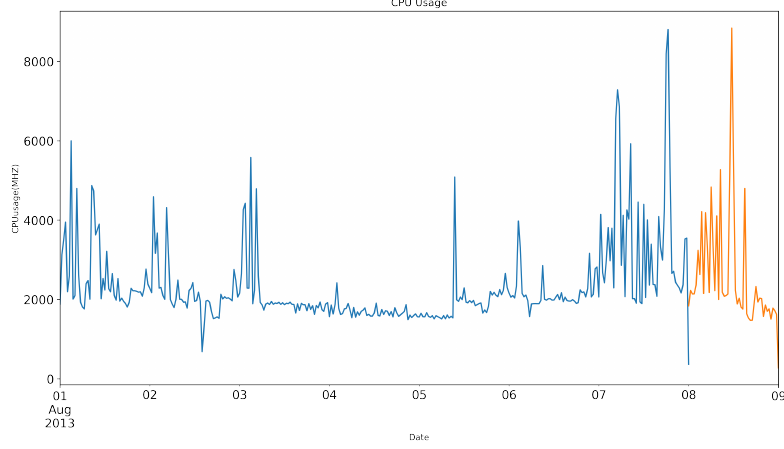
Figure 14. Training and testing result of the CPU